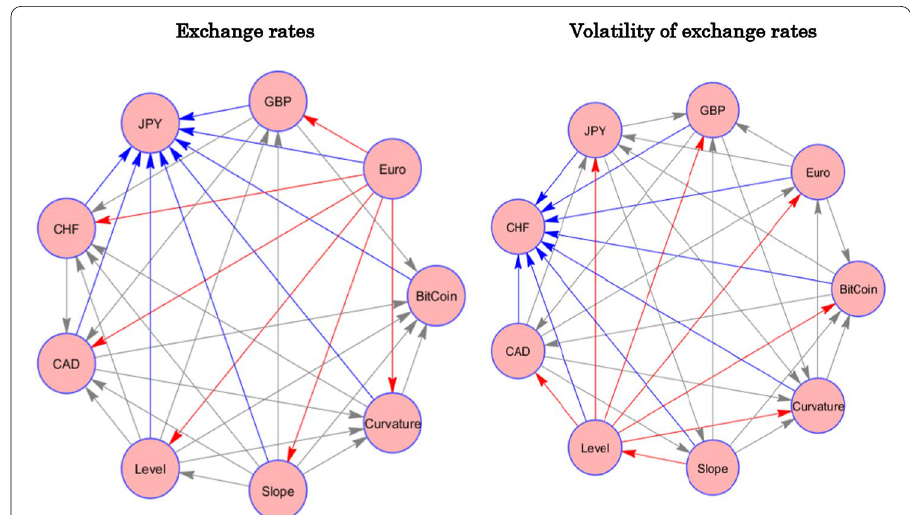
Fig. 1 Pairwise Static Net Connectedness of Components of the yield Curve with the Exchange Rates and the Volatility of the Exchange Rates. Notes : The figures provide a graphical illustration of the network connectedness of the system consisting of the yield curve components (level, slope, and curvature), Bitcoin and safe haven currencies (EURO, GBP Great British Pound, JPY Japanese Yen, CHF Swiss Franc, = = = CAD Canadian Dollar). The left-hand (right-hand) graph shows the network connectedness in terms of = exchange rates (volatility of exchange rates). Arrows indicate the net directional connectedness between two variables in the system with a one-way direction arrow. The source of the arrow shows the transmitter, and the edge of the arrow shows the receiver of the spillover. More arrows mean a more influential variable in the connectedness. A red font arrow means that the variable has the largest transmitter of pairwise spillovers, while a blue means largest receiver of